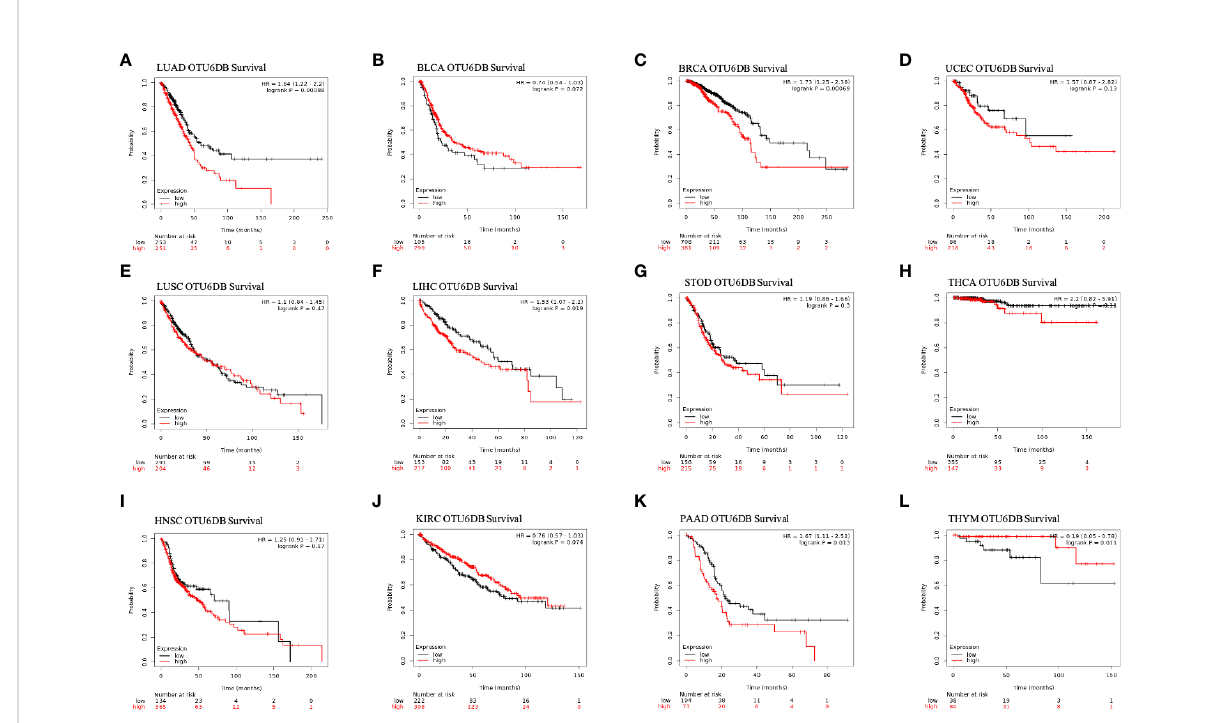
FIGURE 4 Overall survival and OTUD6B expression in the Kaplan – Meier database. (A-L) The relationship between OTUD6B levels and prognosis in indicated tumor